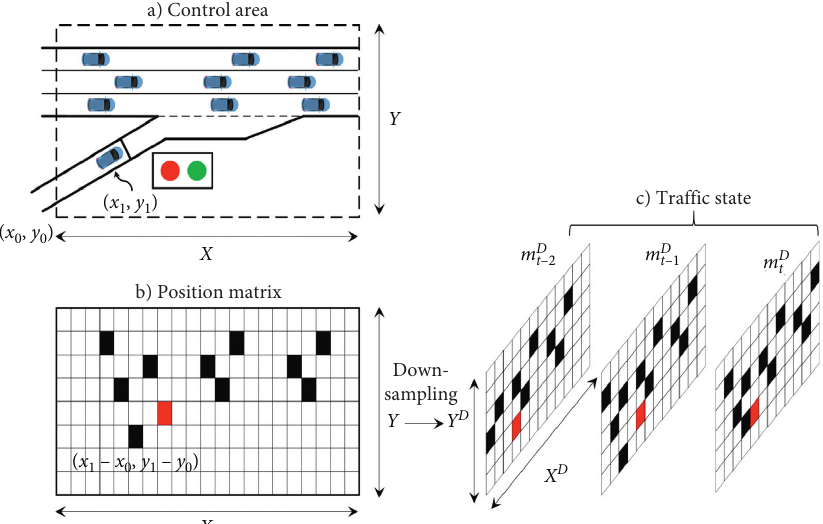
Figure 3: State representation: (a) control area; (b) position matrix m